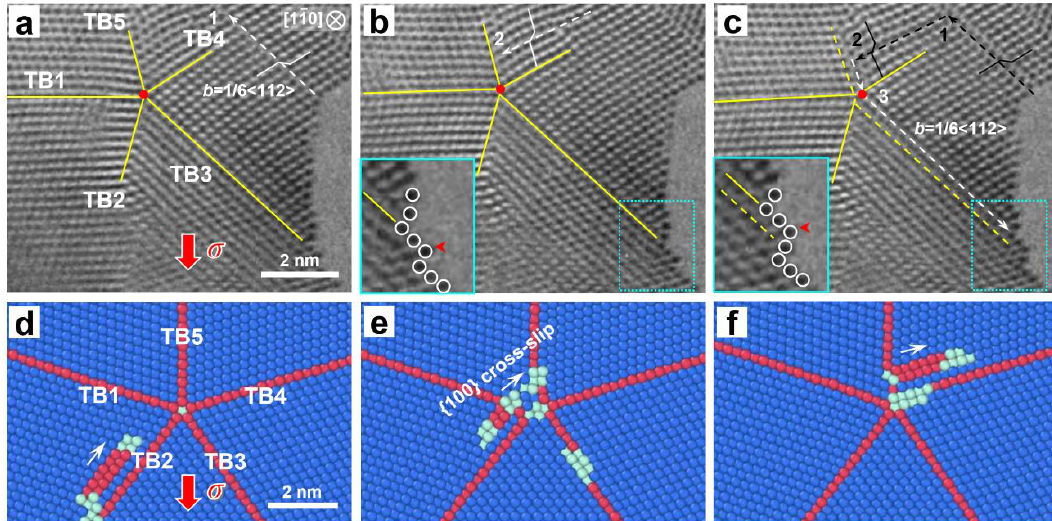
Figure 3. Multiple dislocation cross-slip in penta-twins. ( a – c ) A dislocation experiences cross-slips three times sequentially at the bulk of penta-twins, TBs of penta-twins and the penta-twin core. Insets in ( b , c ) show the variation of atoms at free surface due to the final annihilation of this dislocation at the TB-surface junction. Note that the white and black dashed arrows track the cross-slip routes of two different dislocations that nucleate before and after, respectively. ( d – f ) Transmission-mediated dislocation cross-slip in a penta-twin facilitated by {001} slip mode. Atoms with FCC, HCP and disordered structures were marked in blue, red and cyan, respectively.